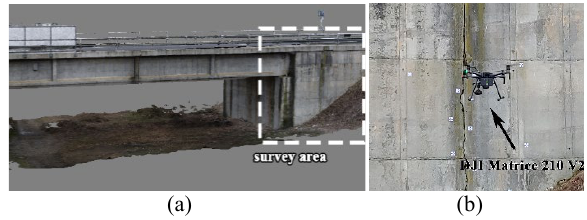
Figure 9 . (a) Ponte Tuna used for the validation test. (b) The crack present on the West abutment.